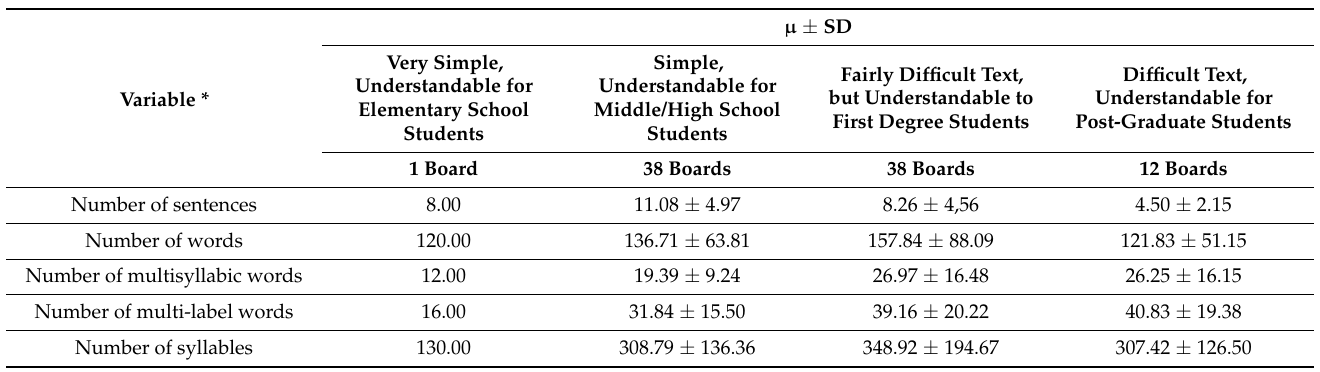
Table 3. Detailed analysis of primary texts on educational boards determined using Promovolt.